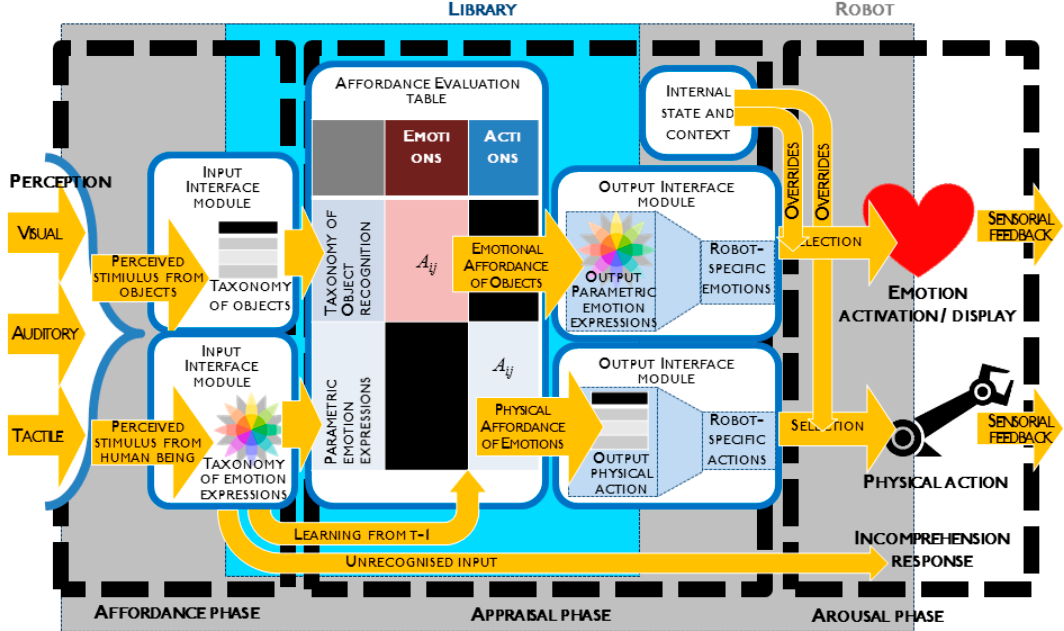
Figure 2. Affordance-Appraisal-Arousal model applied to robots.